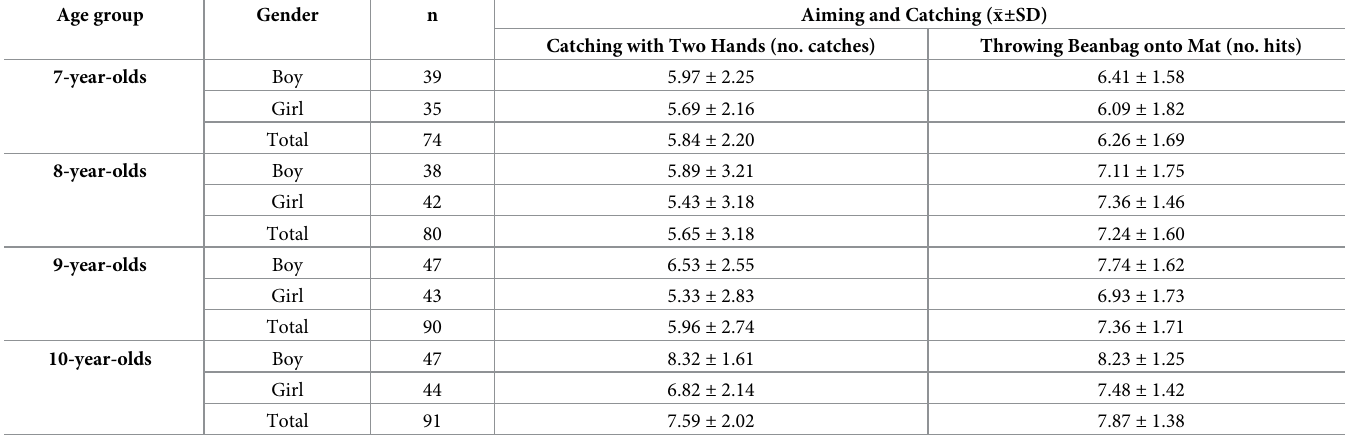
Table 3. Movement performance in the Aiming and Catching subtest of each age group (n =